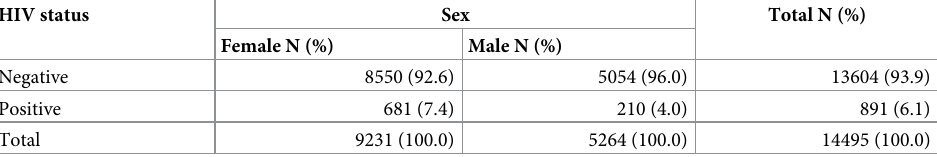
Table 2. HIV status of HBI participants in Benue State, Nigeria by sex.